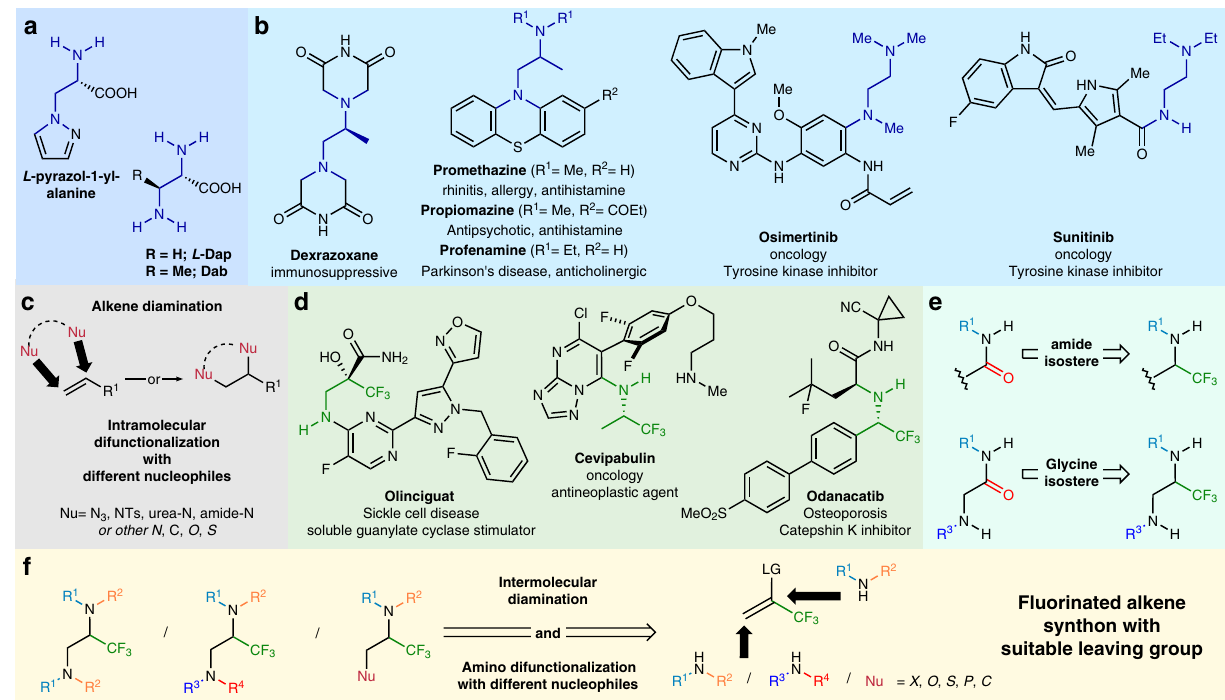
Fig. 1 General overview of ethylene diamines and tri fl uoromethyl amines. a Vicinal diamine backbones in natural products. b Pharmaceutical molecules with vicinal diamine motifs. c Alkene diamination and diazidation methodologies. d Fluoroalkylamine containing drug candidates. e Bioisosteric relations of fl uoroalkylamine moiety. f This work: The intermolecular nucleophilic difunctionalization of a fl uorinated alkene synthon provides a high degree of structural diversity of α -tri fl uoromethyl diamines and substituted tri fl uoropropylamines in one preparative